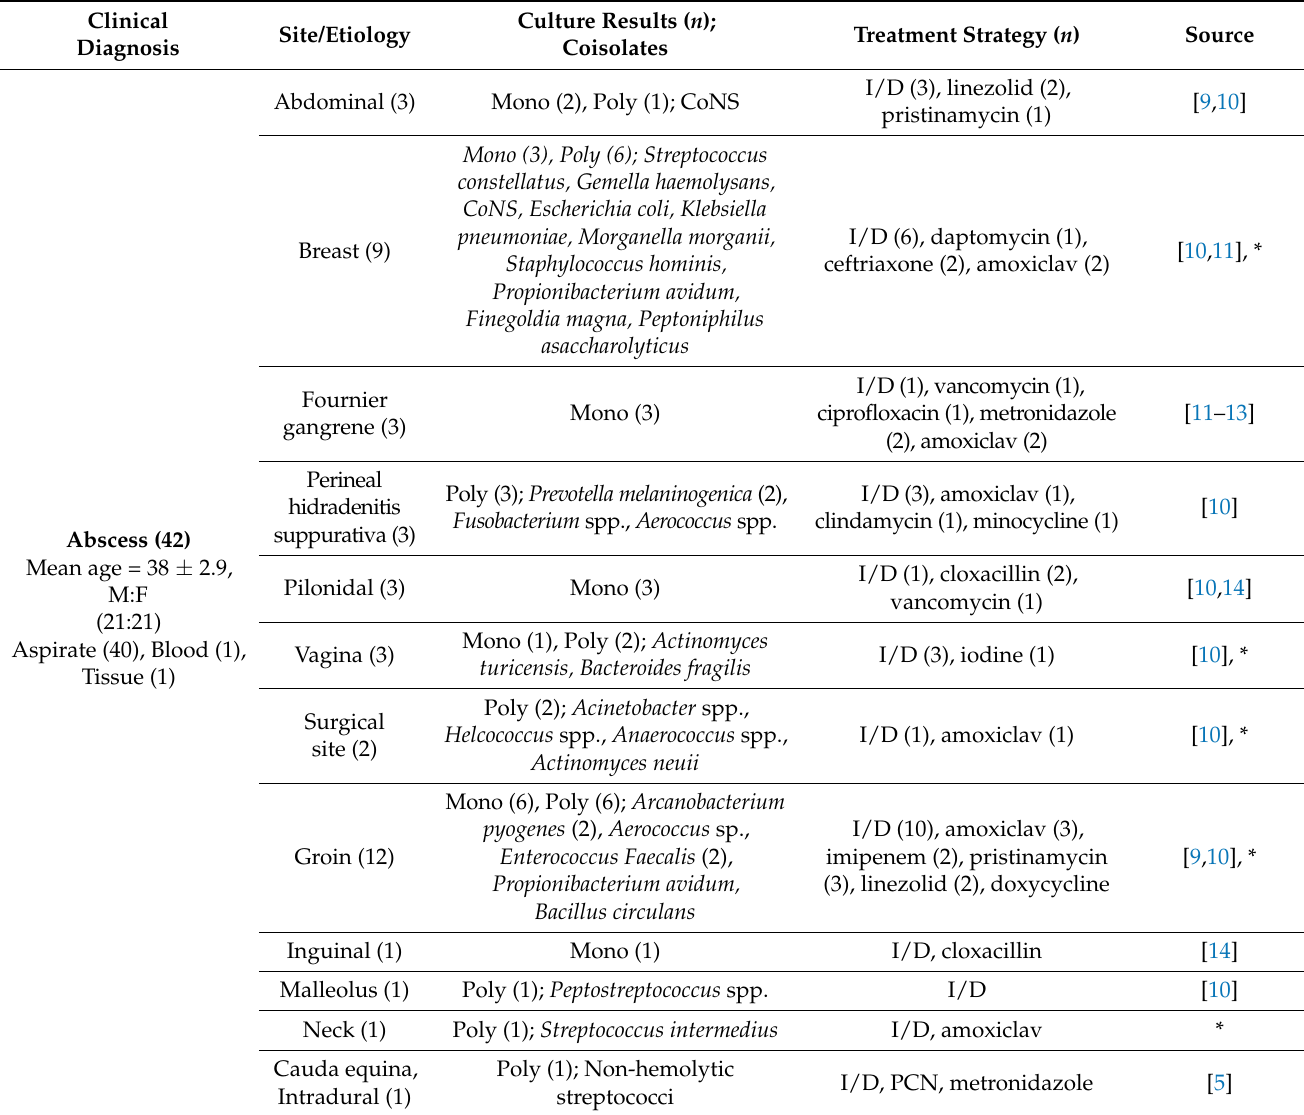
Table 4. Summary of literature review, monomicrobial and polymicrobial culture results, and subsequent management options in A. schaalii -related non-urological